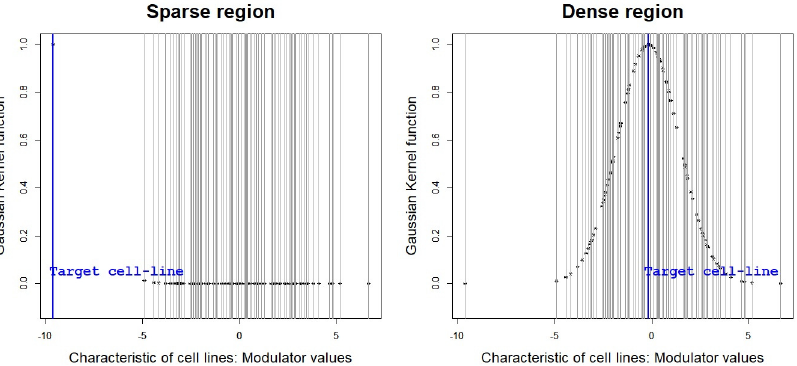
Figure 2. Gaussian kernel function to impose weight on cell lines, where y -axis and x -axis indicate weight and modulator values of cell